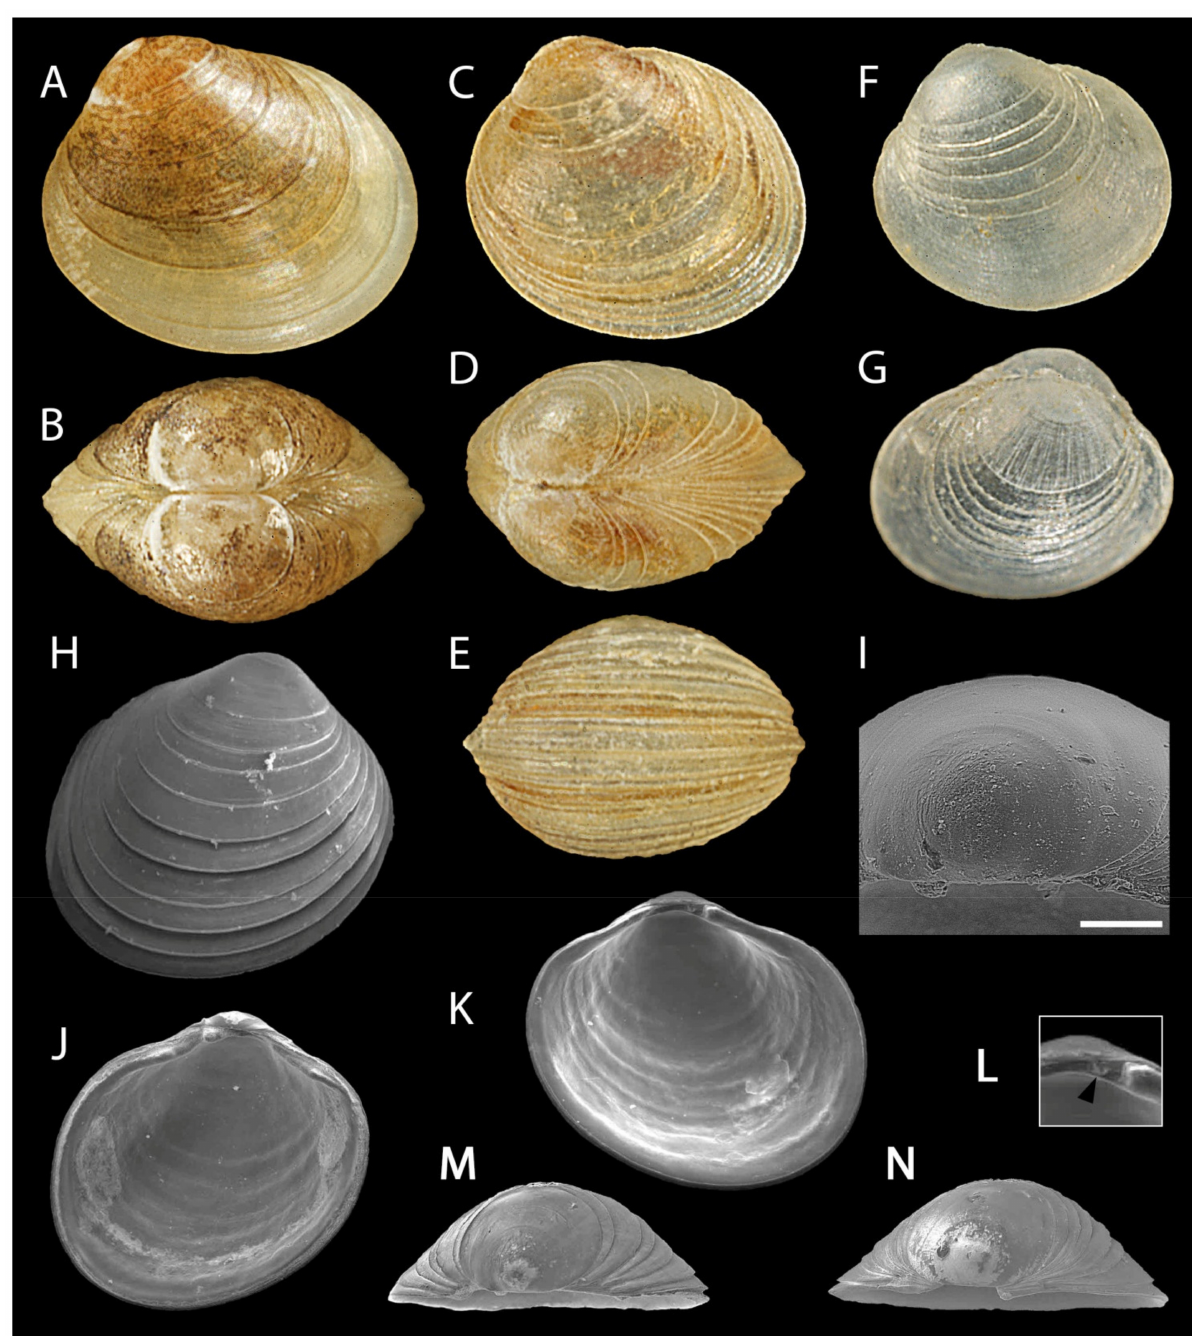
Figure 2. “ Draculamya ” uraniae n. sp. ( A , B ): holotype, off Lazzaro (Italy), L 1.14 mm; ( C – E ): paratype 1, off Gorgona Island (Italy), L 1.08 mm; ( F – H ): paratype 2, Capo Peloro (Italy), L 0.86 mm, ( G ): tilted dorsal view showing prodissoconch pattern; ( H ): paratype 6, off Mallorca Island (Spain), L 1.10 mm, external view of LV; ( I ): paratype 14, off Capraia Island (Italy), RV, detail of the prodissoconch (scale bar 100 µ m); ( J , M ): paratype 5, off Almeria (Spain), L 1.00 mm, RV; ( K , L , N ): paratype 4, off Almeria (Spain), L 1.05 mm, LV, ( L ): detail of the hinge (black arrow points out small